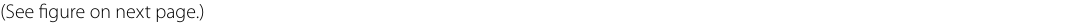
figure on next Fig. 1 The first procedure. a-b On Sep 2, 2020, emergent head NCCT revealed new infarctions in the right internal watershed area. (a. red arrows), head CTP showed an ischemic penumbra of 100.3 mL in the bilateral ICAs (green area). c-h Emergent EVT on Sep 3, 2020: Preprocedural angiogram showed long stenosis with a double lumen sign, distal to the right carotid bulb (c. red arrows indicated a flow-limiting segment), string-like stenosis distal to the left carotid bulb (d. red arrows indicated a flow-limiting segment) with an opening into left PCom A (e. red arrow); The microcatheter was in the true lumen, which was confirmed by post-lesion angiography (f. red arrow); A 6 30 mm Solitaire FR stent was temporarily deployed in × the key flow-limiting segment through a microcatheter (g. red arrows indicated the distal and proximal markers of the stent); After the stent release, angiogram showed that the stenosis of the lesion was reduced, the double-lumen sign disappeared, the anterior blood flow was significantly improved, and a small amount of compensation was made to the left anterior circulation through ACom A (h). i-j On Sep 4, 2020, repeated head NCCT revealed more pronounced infarctions than the pre-procedure status (red arrows), head CTP showed that the perfusion of the blood supply area of the right ICA was recovered, and the penumbra of the blood supply area of left ICA was enlarged to 114.2 mL, compared with that before the procedure (green